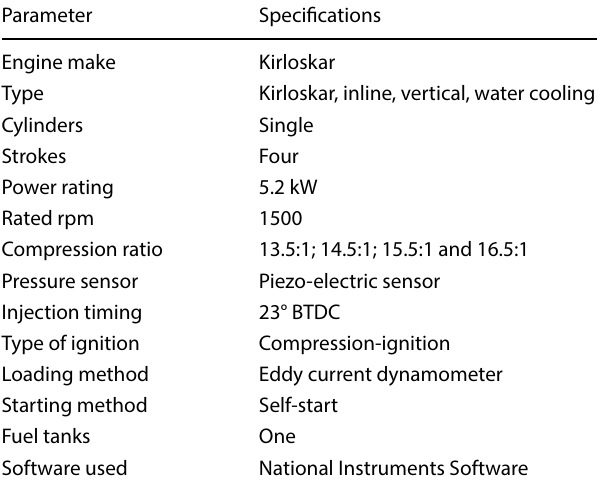
Table 6 The summary of accuracy ranges for the measurements taken on AVG exhaust gas